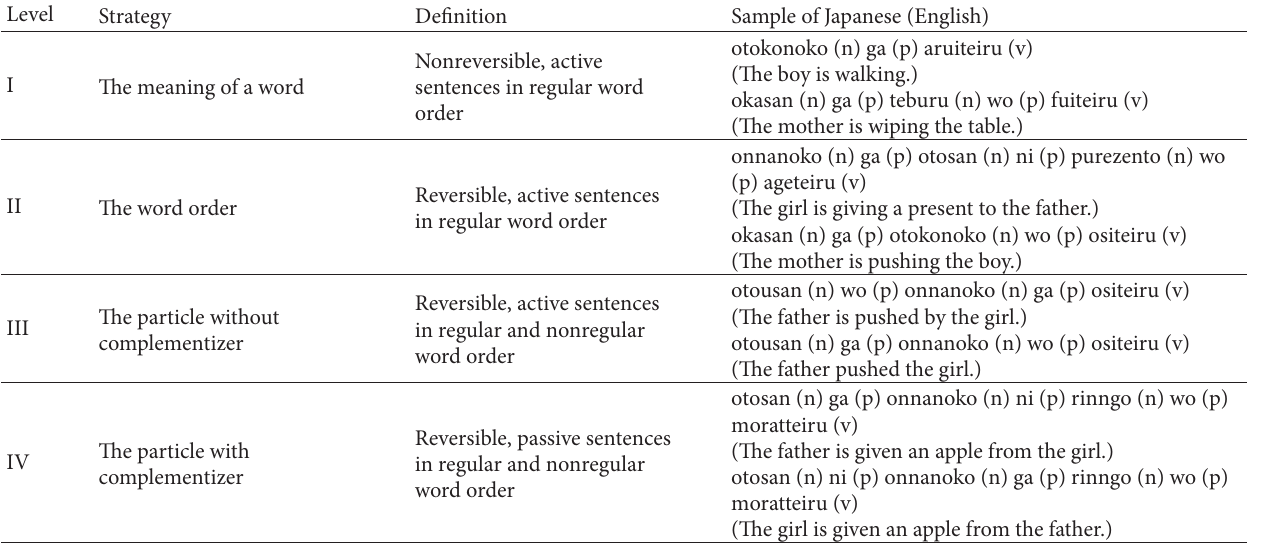
Table 1: Each stage and examples of Syntax Test for